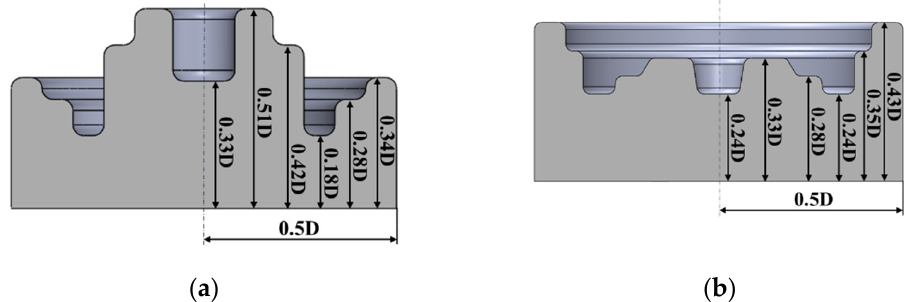
Figure 8. ( a ) First and ( b ) second axisymmetric test forging shapes adopted for the validation of the CNN sub-models.